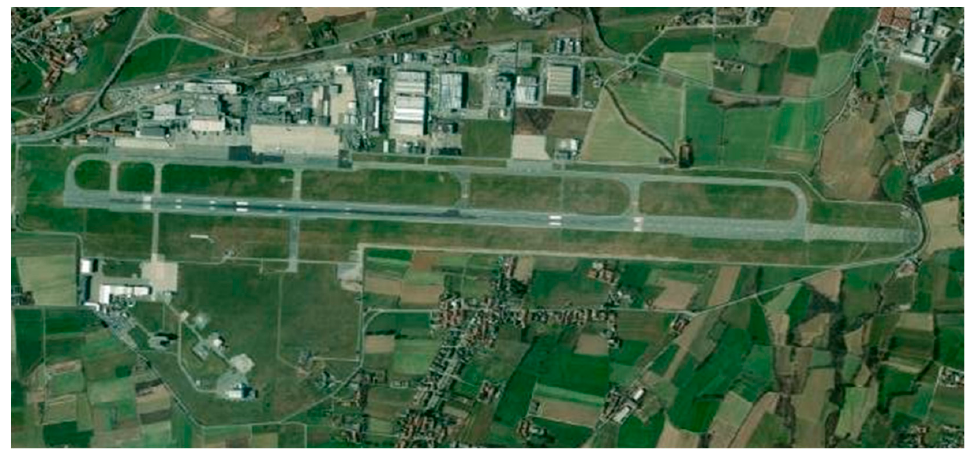
Figure 3. Turin-Caselle Airport (source: www.aeroportoditorino.it accessed on 1 March 2021).